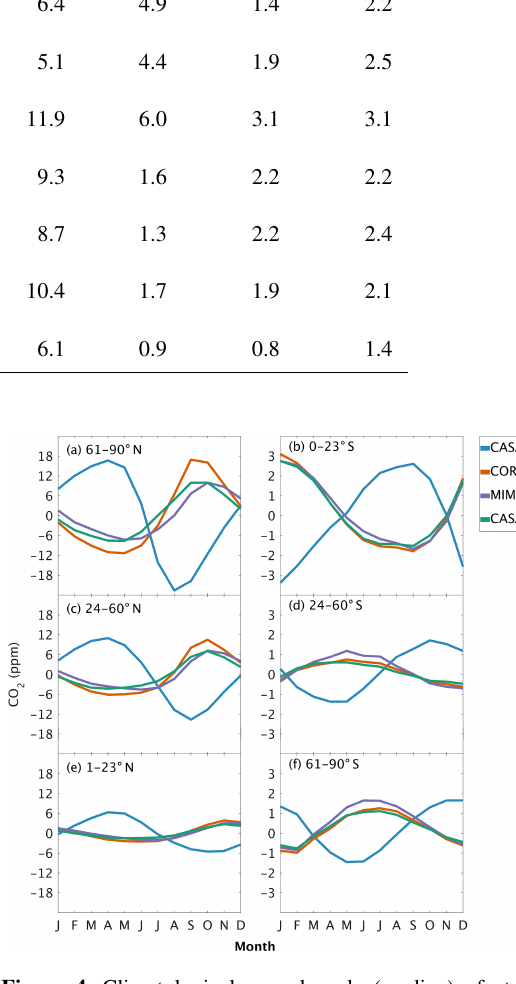
Figure 4. Climatological annual cycle (median) of atmospheric CO 2 simulated from land fluxes (CO NPP , CO HR ) between 1982 and 2 2 2010. Monthly climatology values were created after detrending the CO 2 time series for atmospheric sampling bands in the (a–c) North- ern Hemisphere (d–f) and Southern Hemisphere. Note the change in y -axis scale between the two hemispheres, and the sign of CO NPP 2 reflects the sign reversal of the underlying NPP (positive flux to the atmosphere; Eq.